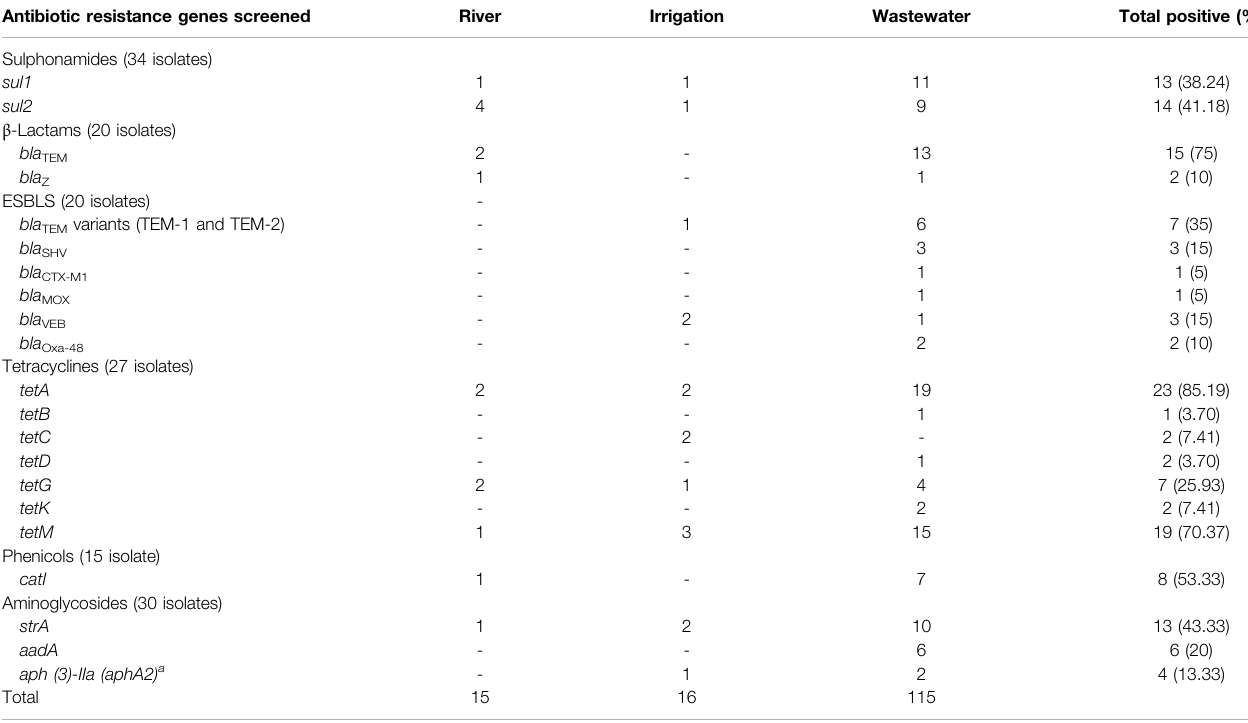
TABLE 4 | Description of the occurrence of resistance genes of Listeria monocytogenes from environmental waters. Antibiotic resistance genes